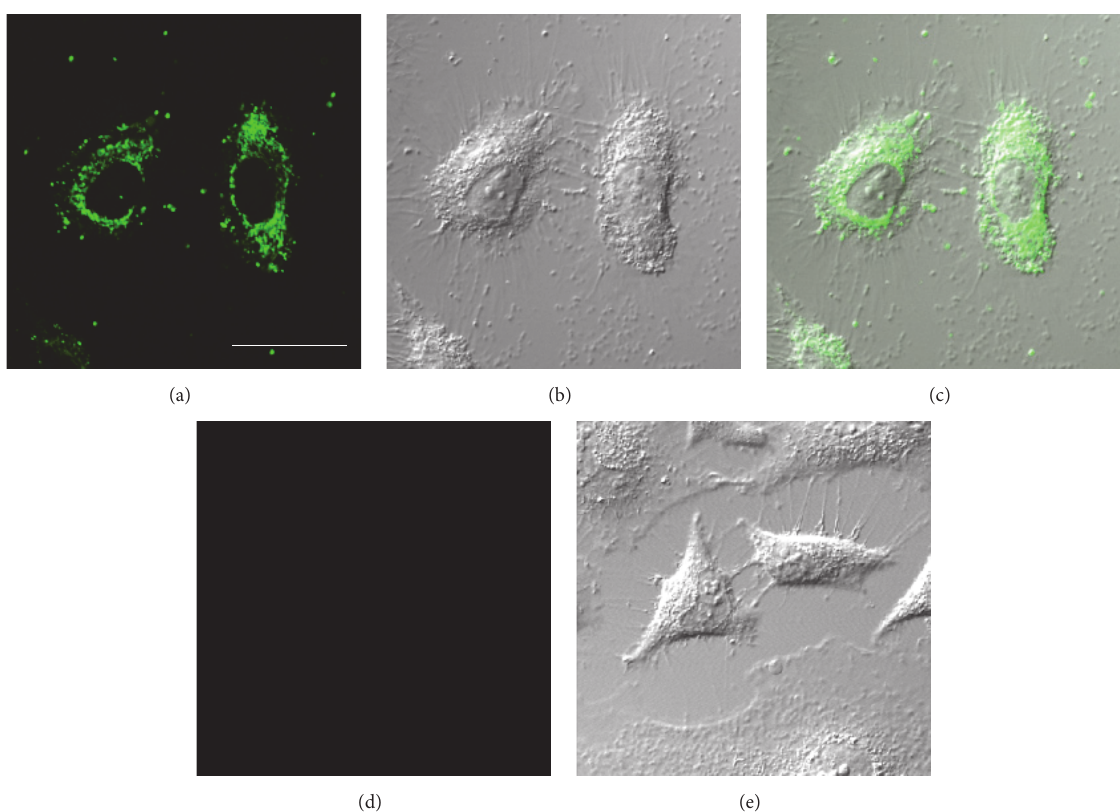
Figure 2: Cellular uptake of ( 8 ) and ( 9 ) in live HeLa cells. (a) fluorescence image, (b) DIC (differential interference contrast) image, (c) merge image of (a) and (b) from ( 8 ) (ibuprofen conjugate) treated cells, (d) fluorescence image, and (e) DIC image from ( 9 ) (control) treated cells. Scale bar: 20 𝜇